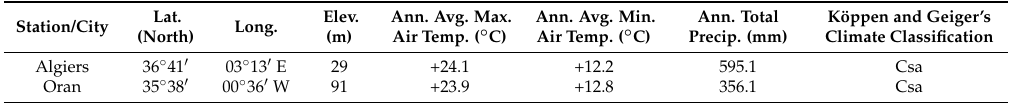
Table 1. Geographic characteristics, annual average maximum and minimum air temperatures, annual average total precipitation relative for the period 1986–2015 for the 6 selected stations and climate classification of their associated cities according to Köppen-Geiger climate classification criteria [30]. Csa refers to a warm temperate climate with dry and hot summers and Bwh to a desert and a hot arid